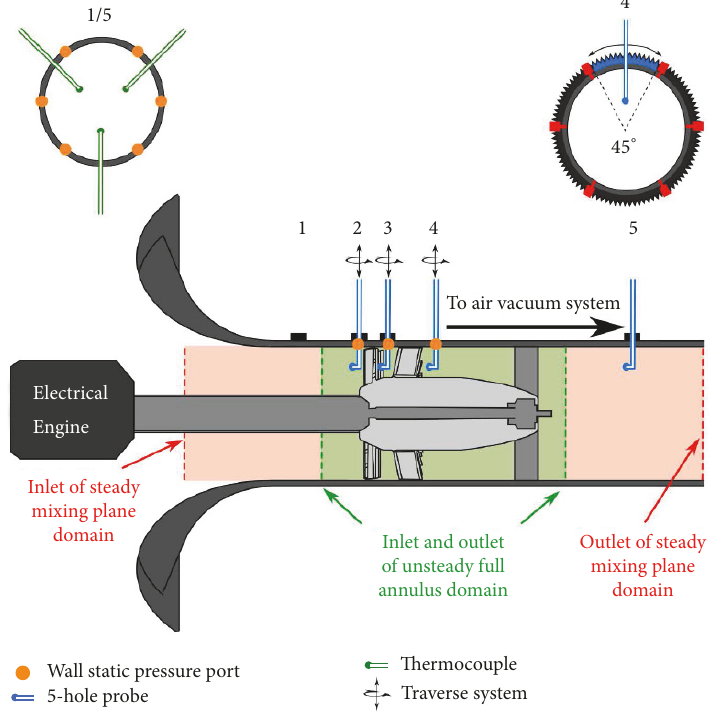
Figure 2: Illustration of the deep windmilling test facility (willow) and the numerical